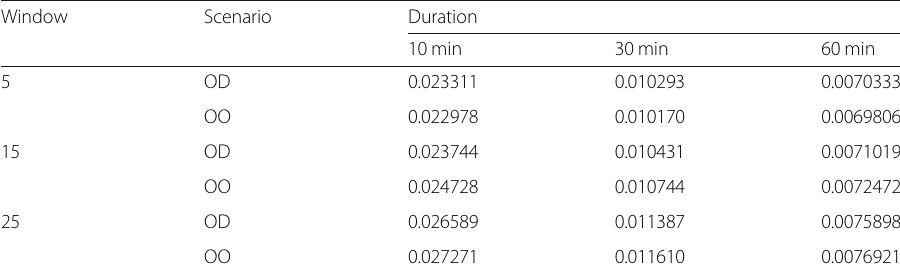
Table 2 Relative difference (as percentages)